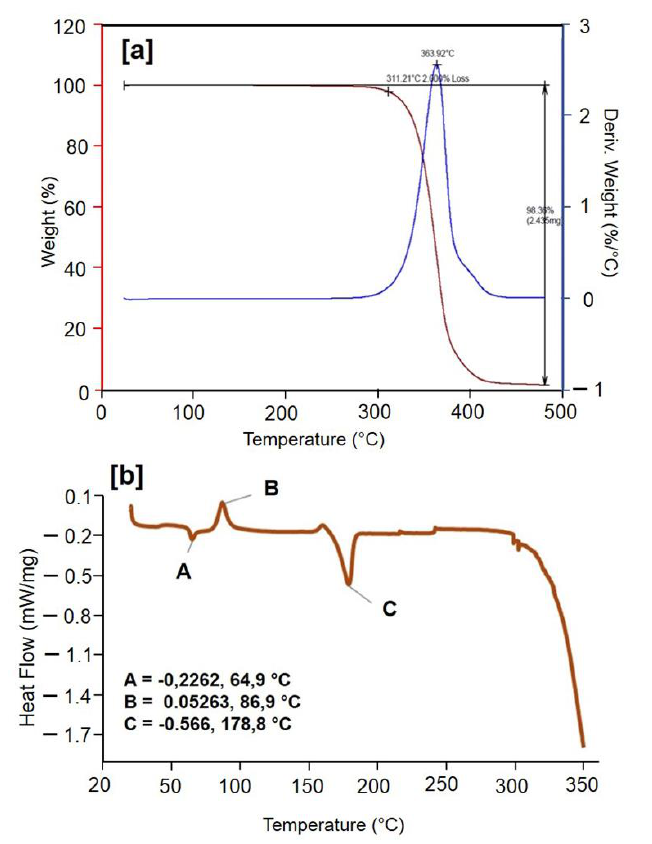
Figure 3. ( a ) TGA curve of PLA filament; ( b ) the differential scanning calorimetry (DSC) curve of 222 PLA